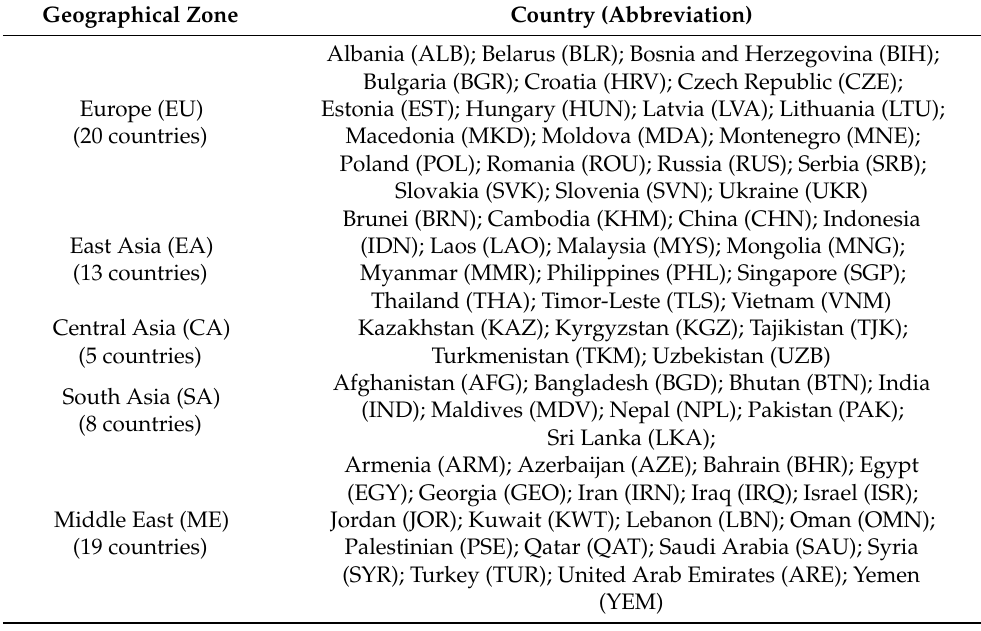
Table 1. The countries in different geographical zones throughout the Pan-Third Pole region.